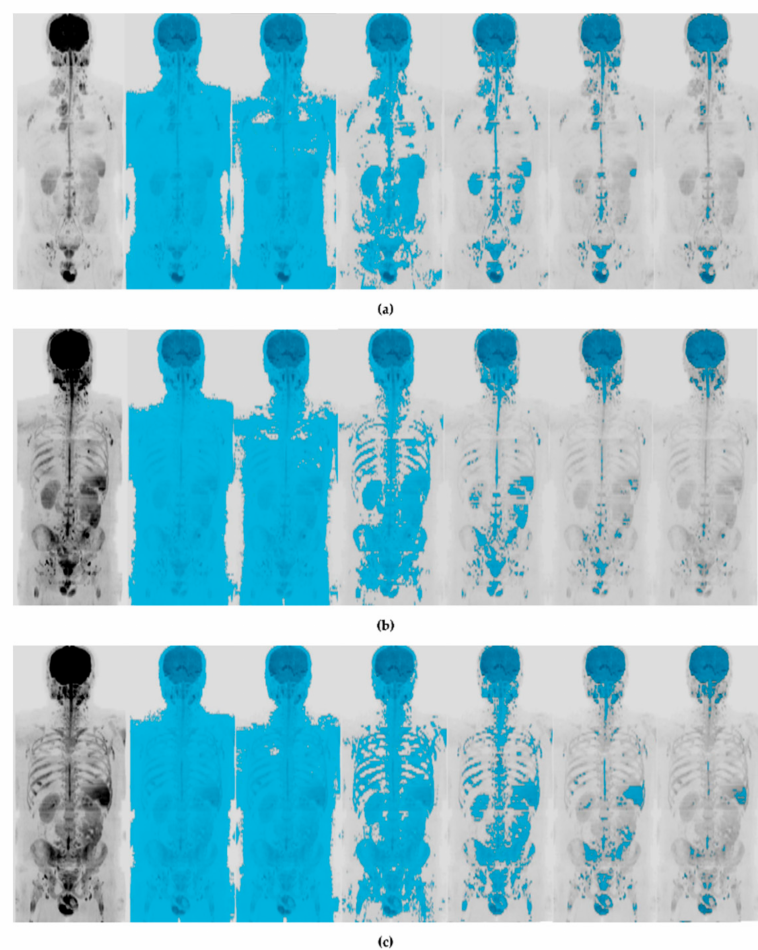
Figure 3. ( a ) Maximum intensity projection (MIP) of WB-DWI images at b800 at baseline (T0) and its relative masks at 5%, 10%, 20%, 40%, 60%, and 80%. ( b ) Maximum intensity projection (MIP) of whole-body DWI (WB-DWI) images at b800 at interim (T1) and its relative masks at 5%, 10%, 20%, 40%, 60%, and 80%. ( c ) Maximum intensity projection (MIP) of WB-DWI images at b800 at the EOT (T2) and its relative masks at 5%, 10%, 20%, 40%, 60%, and 80%. Images are from a patient showing complete metabolic response (according to Lugano evaluation) both at T1 and